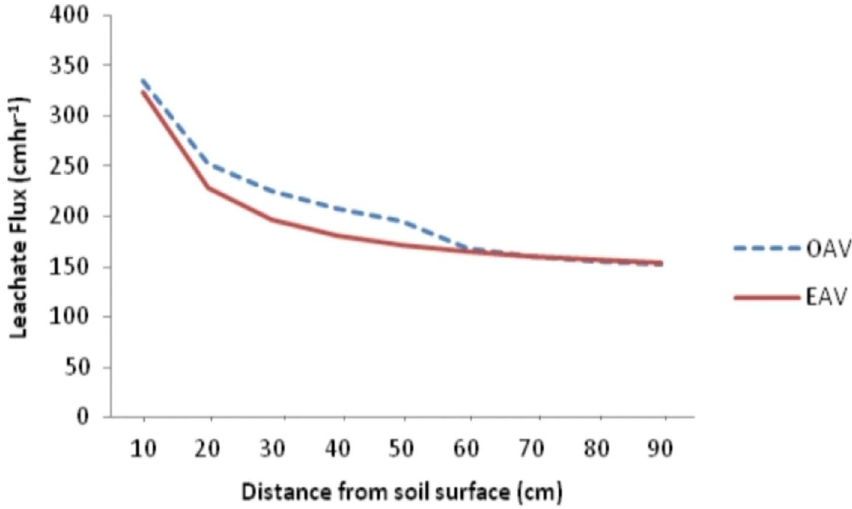
Figure 9. Pattern of observed and estimated leachate flux for average leachate flux in the dumpsite soil.